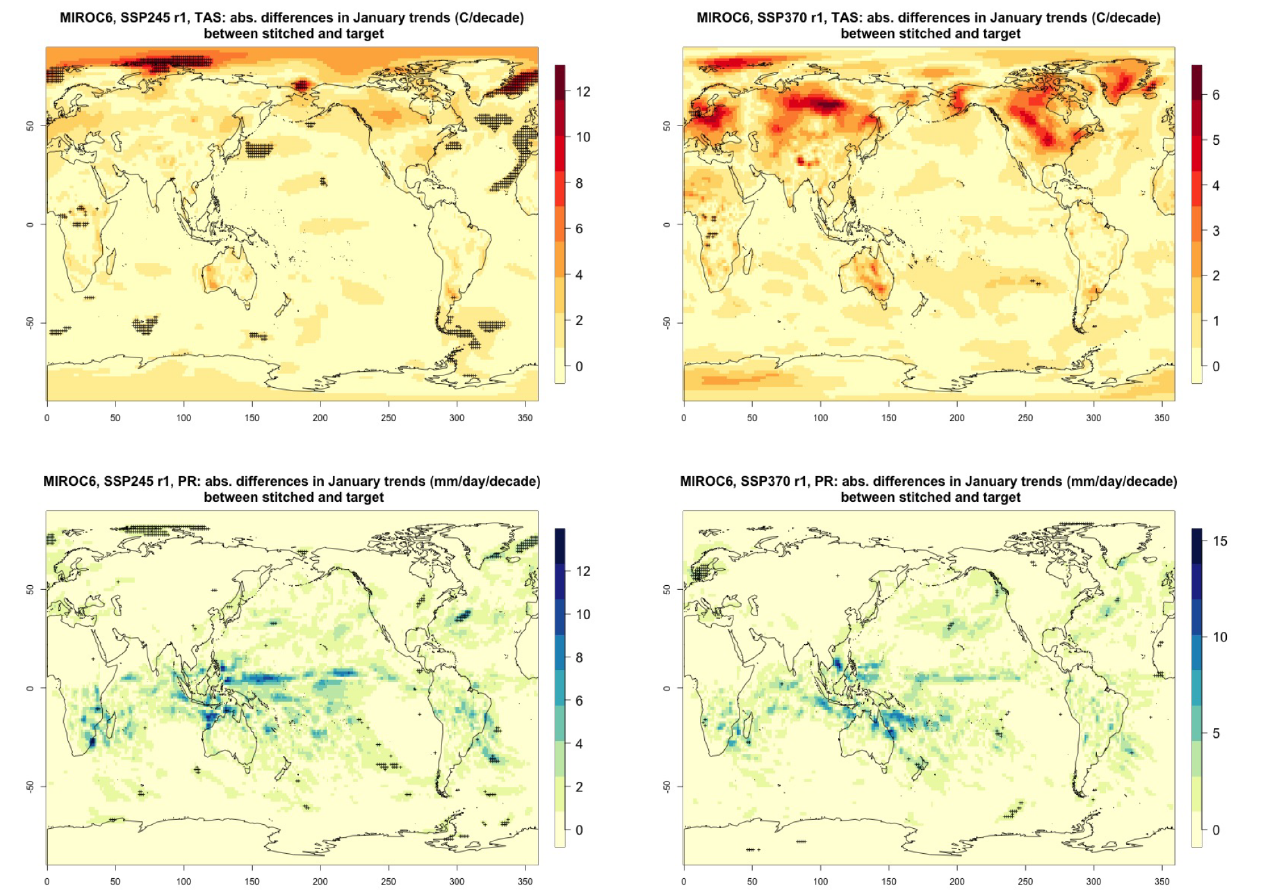
Figure C6. Absolute difference in decadal trends of January temperature (TAS) and precipitation (PR) between stitched and target realiza- tions. The value of the difference is expressed by the color scale, and we marked as significant with black crosses those locations where the 95% confidence intervals of the trends computed from target and stitched time series do not overlap, indicating statistically significant differences. Emulation of MIROC6, January time series over 2015–2100, for SSP2-4.5 and SSP3-7.0. First realization.